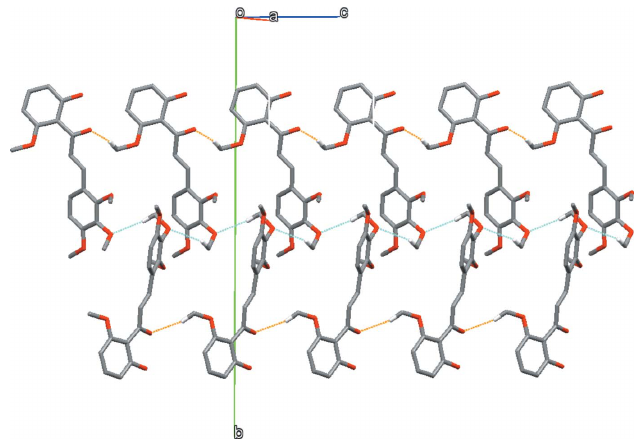
Figure 1 The molecular structure of the title compound, showing the atom- labelling scheme with displacement ellipsoids drawn at the 30% probability